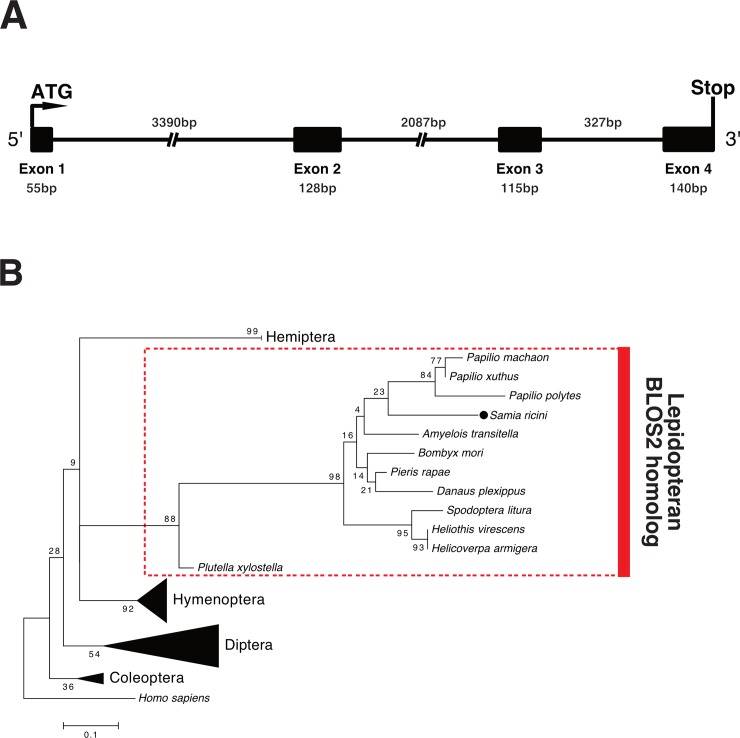
Genomic structure and phylogenetic analysis of Samia ricini biogenesis of lysosome-related organelles complex 1, subunit 2 (SrBLOS2).(A) Genomic structure of SrBLOS2. Numbers show the sizes of exons and introns. (B) Phylogenetic tree of insect BLOS2 homologs. The tree was constructed using MEGA7.0 (Kumar et al., 2015). Human BLOS2 sequence was included as an outgroup.